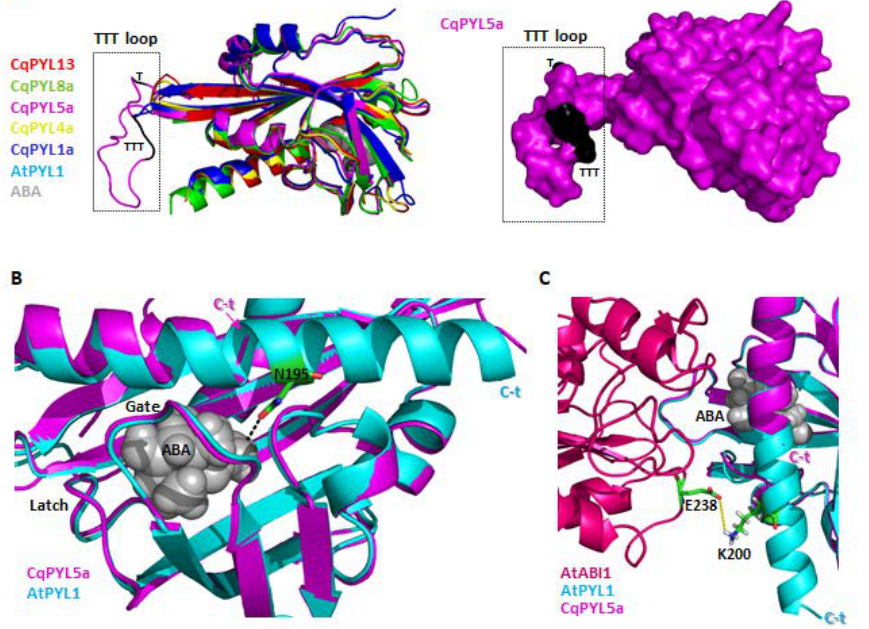
Figure 10. CqPYL5 topology analysis. ( A ). Structural alignment of CqPYL8a, CqPYL5a, CqPYL4a, CqPYL1a, AtPYL1 showed as cartoons (left) and CqPYL5a protein suface (right). TTT loop was indicated. ( B ). Structural alignment of CqPYL5a and AtPYL1 showed as cartoon. Gate and latch loop were indicated. Residue N95 from AtPYL1 was showed as stick view. C-t: C-terminal domain. ( C ) Protein structure of the arabidopsis ternary complex PYL1-ABA-ABI was aligned to CqPYL5a and showed as cartoon. Residues E238 and K200 from AtABI1 and AtPYL1, respectively were showed as sticks. Yellow dotted line: a putative polar